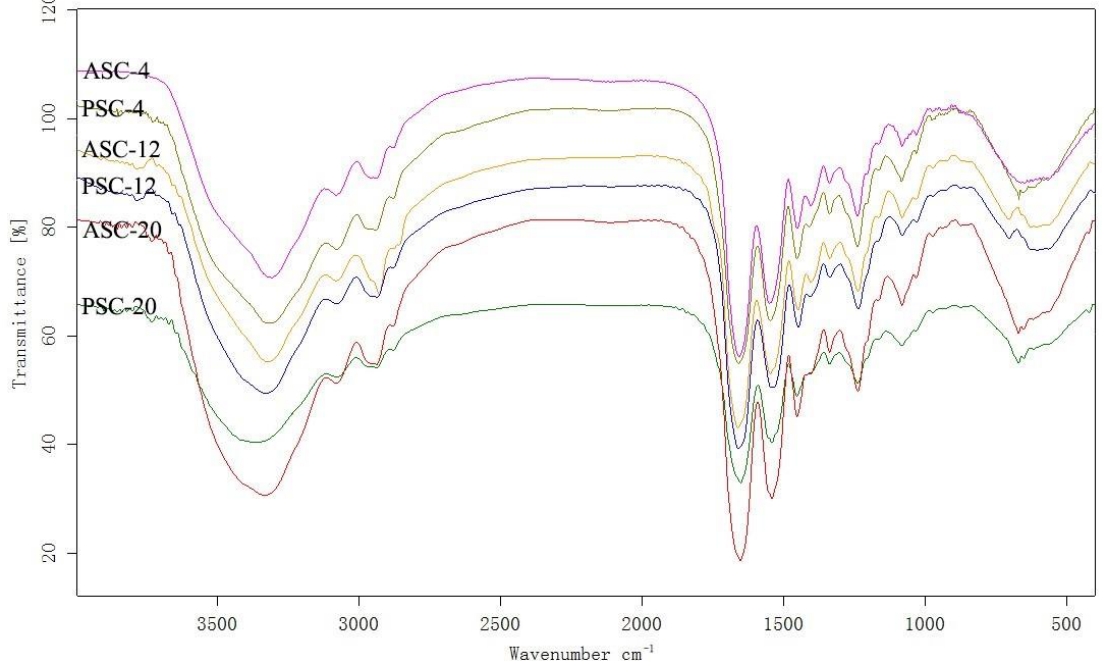
Figure 3. FTIR spectra of ASC and PSC extracted at 4, 12, and 20 °C from the skin of pufferfish. ASC: acid-solubilized collagen; PSC: pepsin-solubilized collagen. ASC: acid-solubilized collagen; PSC: pepsin-solubilized